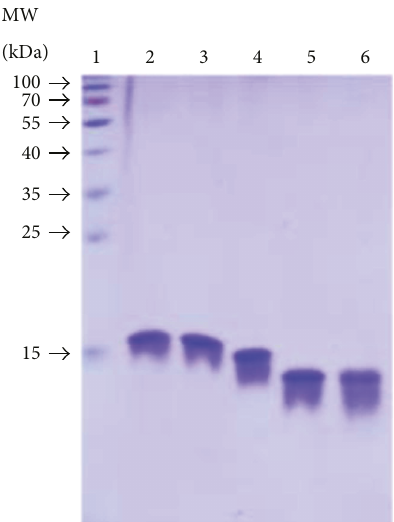
Figure 1: SDS-PAGE analysis of the recombinant THUNP, THUA, THU, HUNP, and HUA. An aliquot (2 μ g) of the recombinant THUNP, THUA, THU, HUNP, and HUA was resolved by SDS-PAGE (15%) and stained with Coomassie Brilliant Blue. Lane 1: molecular weight marker, lane 2: THUNP, lane 3: THUA, lane 4: THU, lane 5: HUNP, and lane 6: